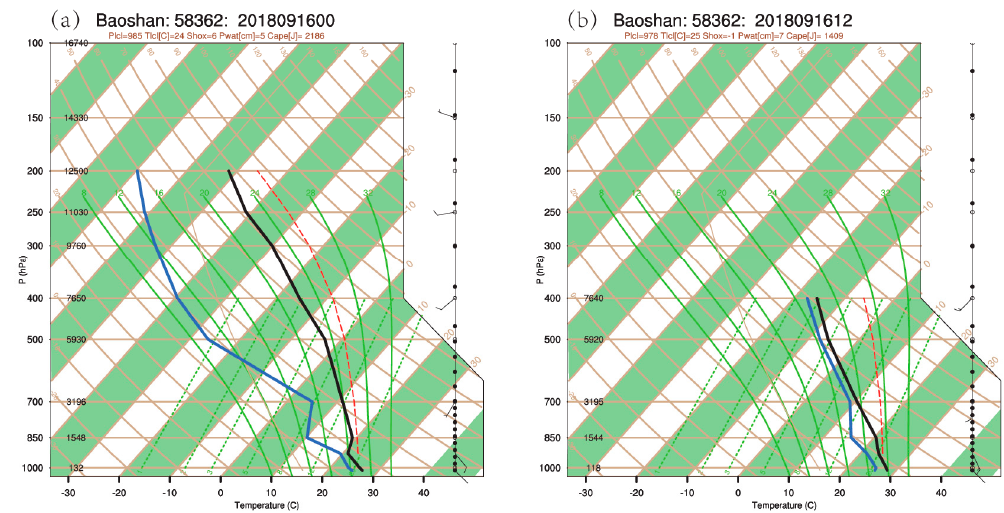
Figure 6. Soundings at Baoshan Station (No. 58362) in Shanghai at ( a ) 0000 UTC and ( b ) 1200 UTC 16 September 2018.